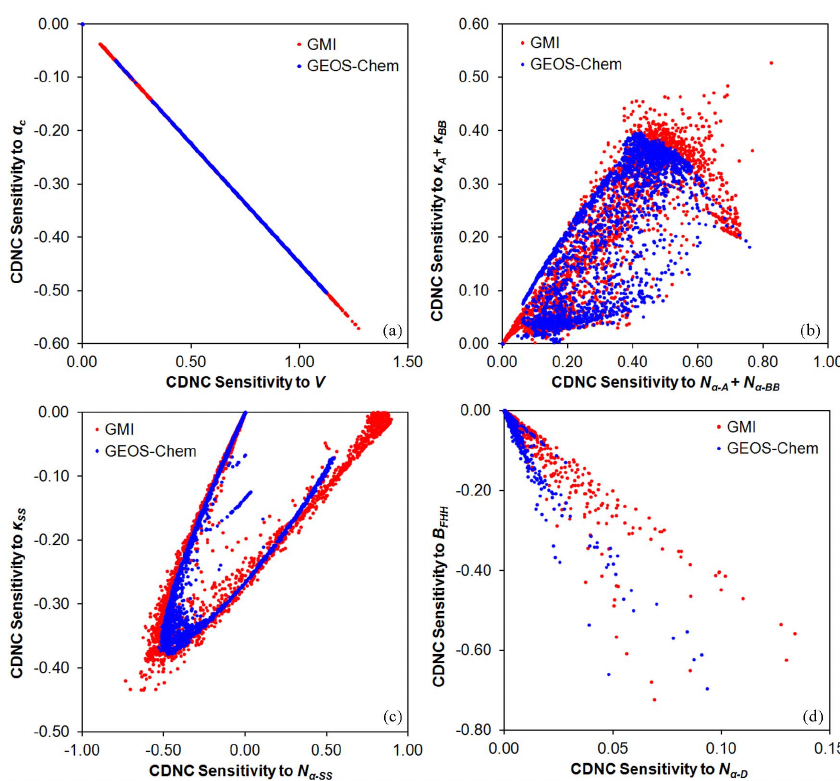
Fig. 6. Comparison between the predicted annual mean cloud droplet number concentration sensitivity to (a) updraft velocity ( V ) and uptake coefficient ( α c ), (b) anthropogenic and biomass burning aerosol number concentration ( N α − A + N α − BB ) and hygroscopicity ( κ A + κ BB ), (c) sea salt aerosol number concentration ( N α − SS ) and hygroscopicity ( κ SS ) and (d) dust aerosol number concentration ( N α − D ) and B FHH adsorption parameter, derived from the aerosol concentration fields of GEOS-Chem and GMI models for the lowest cloud-forming